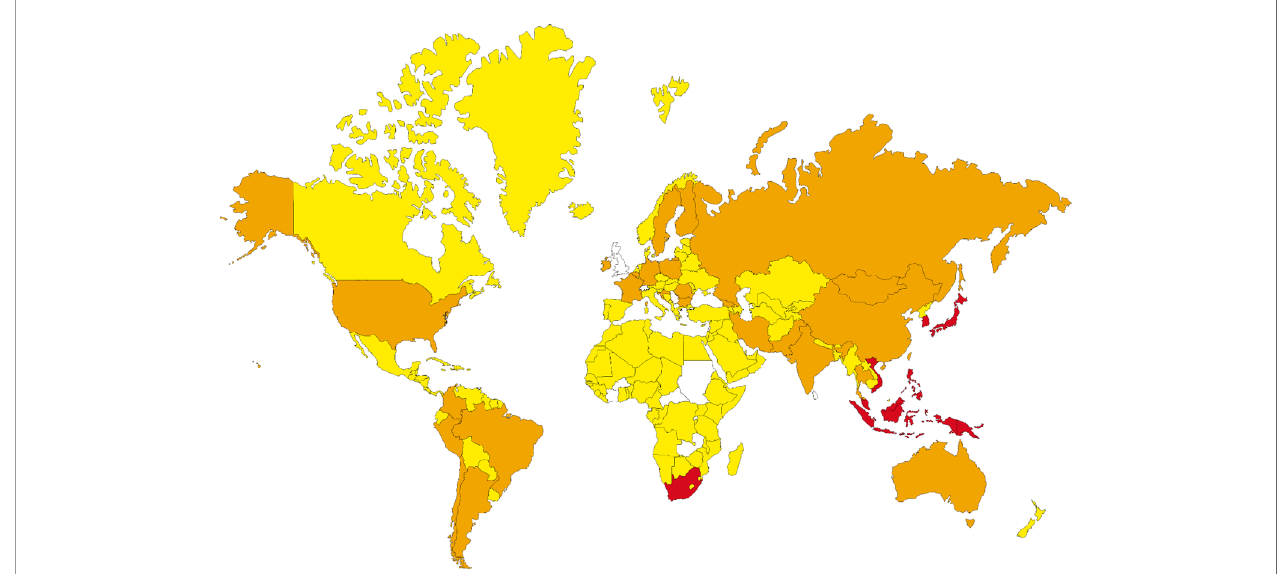
FIGURE 2 | The population coverage prediction for most potent SARS-CoV-2 peptides (red: 100%-75%, orange: 75%-50%, yellow: 50%-25% and regions without data, white: 25%-0% of